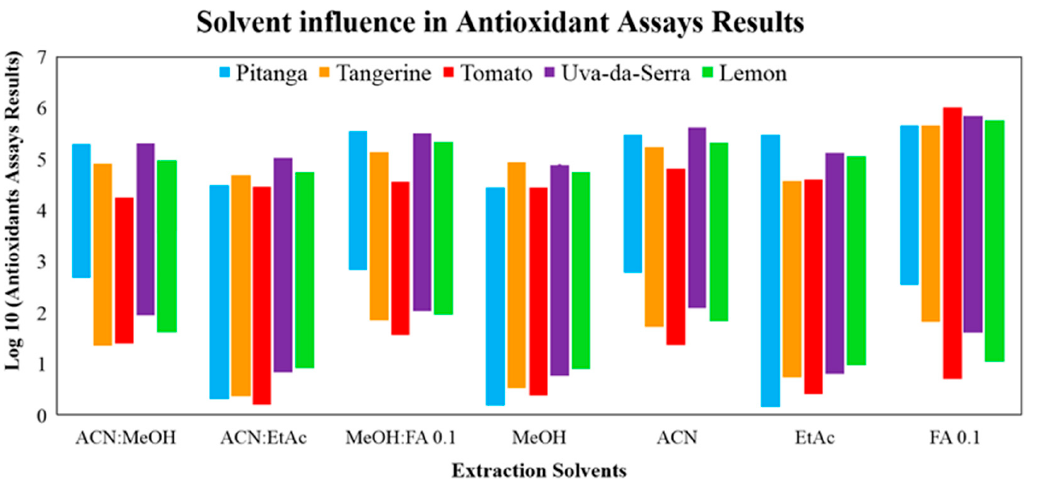
Figure 2. The influence of the extraction conditions on the antioxidants assays performance was assessed by measuring the TAC, TPC and TFC for each fruit extract (pitanga, tangerine, tomato, uva-da-serra and lemon) obtained using each of the seven solvent extraction conditions: methanol—MeOH, acetonitrile—ACN, ethyl acetate—EtAc, formic acid 0.1%—FA, ACN:MeOH (4:1, v/v ), ACN:EtAc (1:1, v/v ) and MeOH:FA (19:1, v/v ). Log 10 was applied to results obtained normalize the data obtained and allow a better comparison of the best extraction